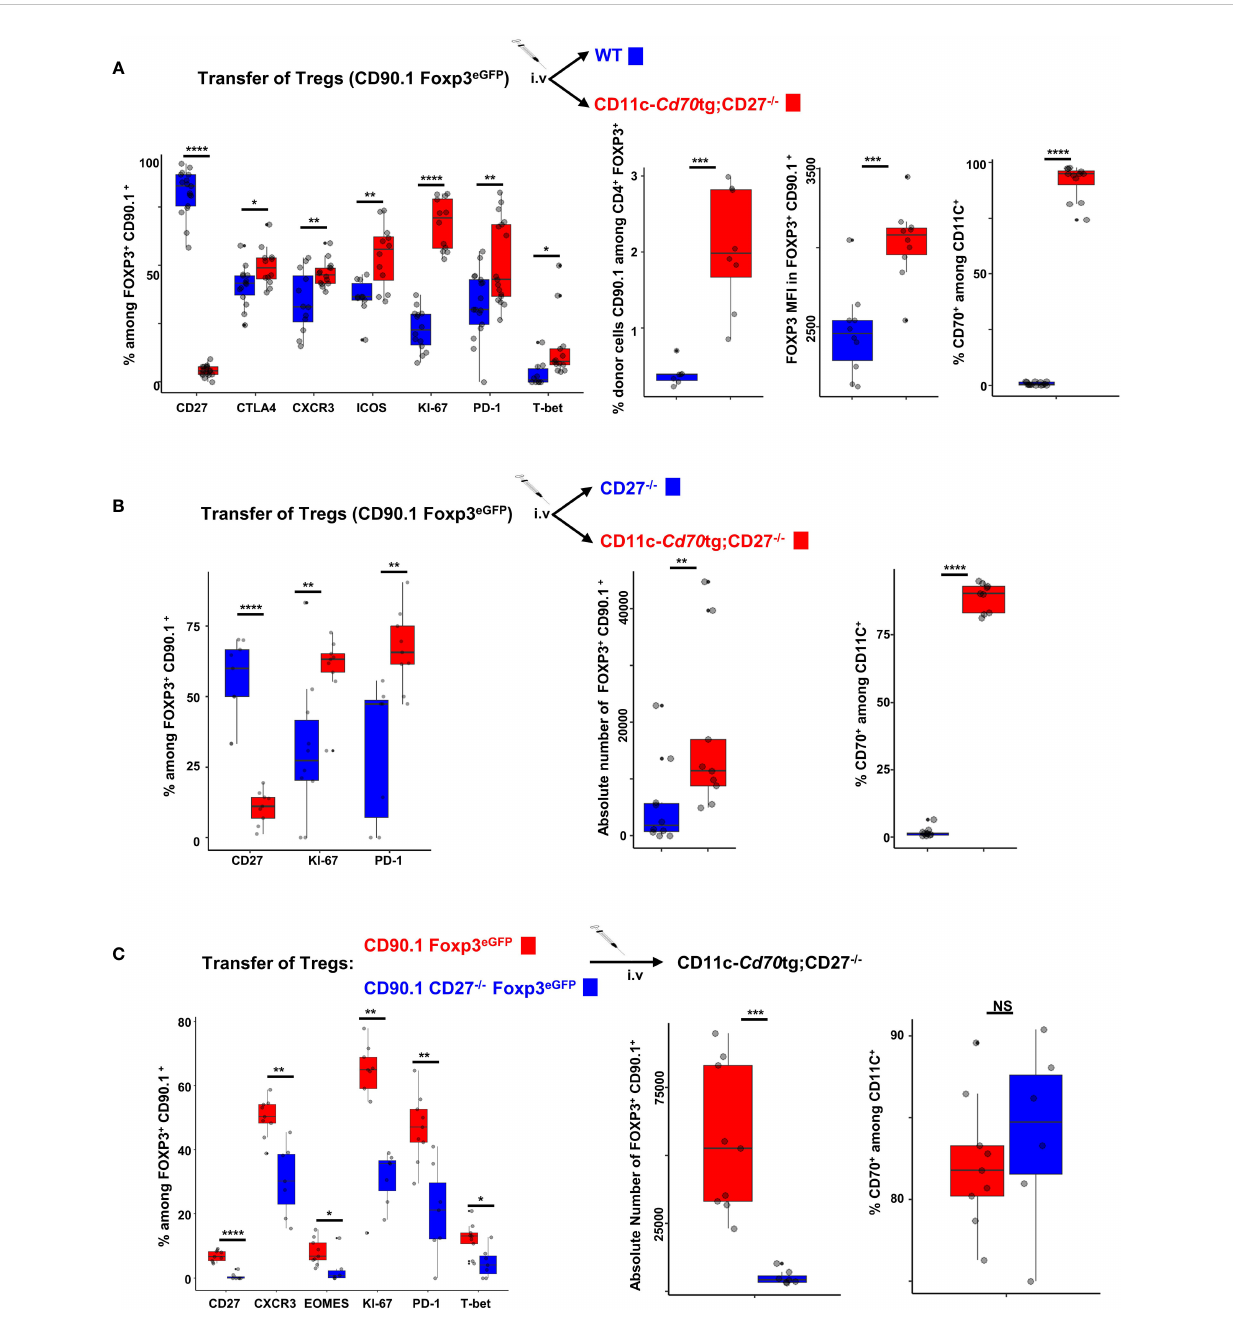
FIGURE 5 Cell autonomous activation/differentiation of Tregs upon CD27 engagement. (A, B) 5 x 10 5 Tregs puri fi ed from Foxp3eGFP CD90.1 mice were injected i.v. into CD11c- Cd70 tg;CD27 -/- recipients and either WT (A) or CD27 -/- (B) as control recipients. (C) Tregs were puri fi ed from Foxp3eGFP CD90.1 mice either CD27 competent or de fi cient (CD27 -/- ) and 5 x 10 5 cells were injected i.v. into CD11c- Cd70 tg;CD27 -/- recipients. Spleen cells were analyzed ex vivo by fl ow cytometry 7 days after injection. Data show the proportion of transferred Tregs (Foxp3 + CD90.1 + ) expressing the proliferation marker Ki67, transcription factors (eomes, T-bet), chemokine receptor CXCR3 and inhibitory receptors (ICOS, CTLA-4 and PD-1) as well as the absolute number of CD90.1 + Tregs recovered. Controls include CD27 and CD70 staining. Data are representative of 3 independent experiments with 4 mice per group. Bars represent median ± SD. Unpaired t-test was used to determine statistical differences followed by FDR correction for multiple comparisons (*p < 0.05; **p < 0.01; ***p < 0.001; ****p < 0.0001; ns, not signi fi